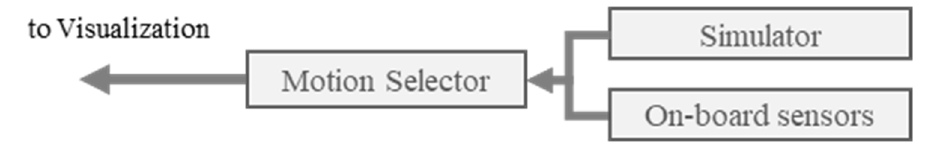
Figure 6. Vessel motion generator module. The operator can choose on-board sensors for real-time motion data or virtual motion for a simulation.